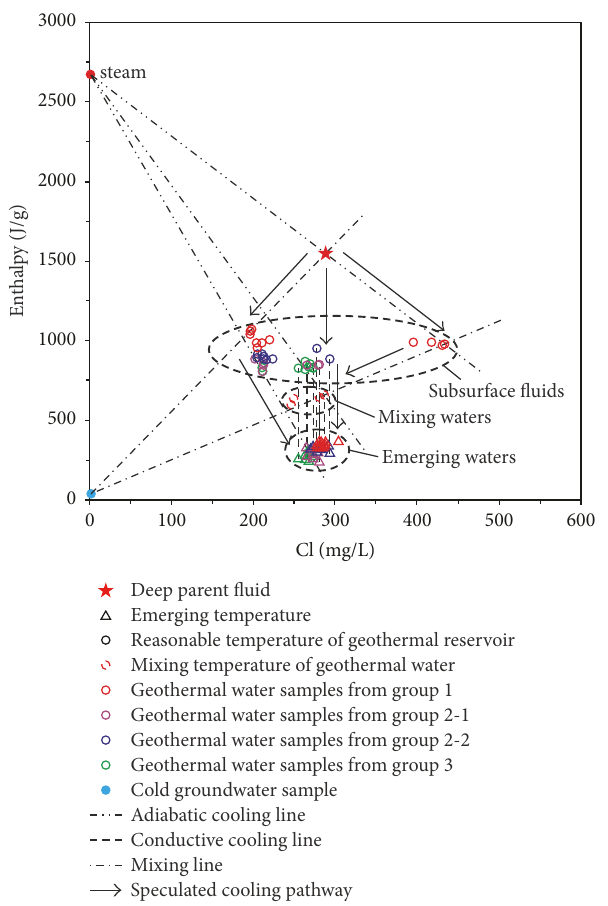
Figure10:Enthalpy-chlorideplotforthegeothermalspringsamples of the research